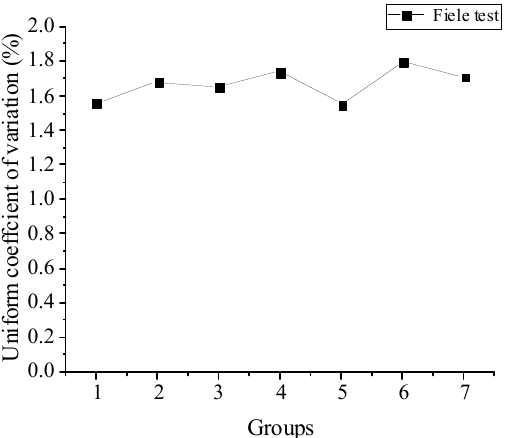
Figure 15. Analysis of uniform coefficient of variation in the field test. The minimum coefficient of variation of uniformity of fertilizer discharge was 1.55% and the maximum was 2.2%. The results of the field experiment were larger than those